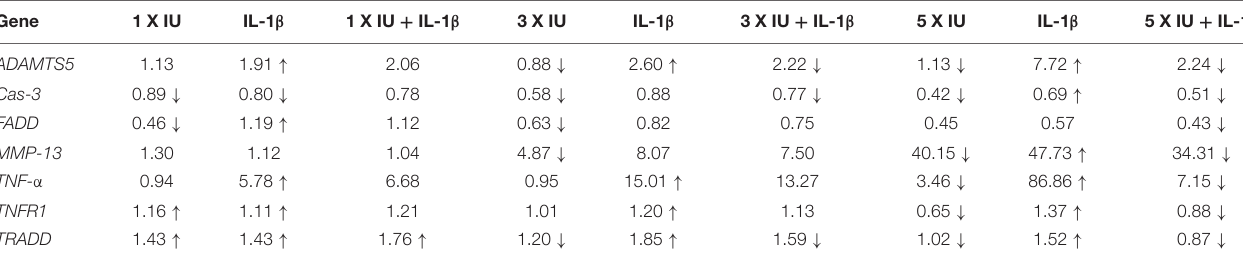
TABLE 1 | Summary of gene expression in cultured chondrocytes under the regulation of IL-1 β and LLLI ∗ .